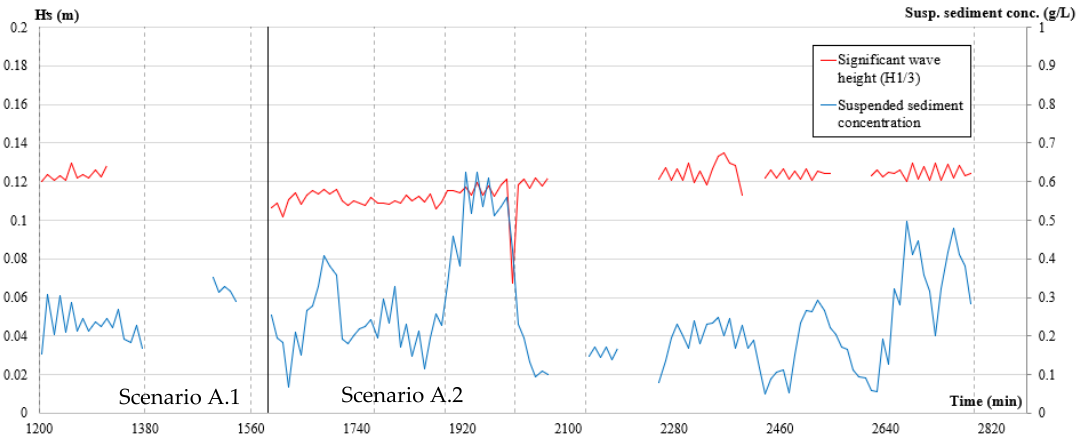
Figure 5. Recorded data timeline for significant wave height and suspended sediment concentration for the A.1 and A.2 scenarios. The vertical black line represents the transition between scenarios A.1 and A.2. The vertical black dashed lines represent the instants when the equipment was stopped.